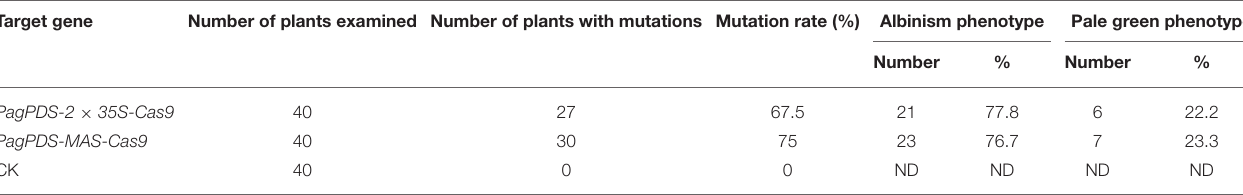
TABLE 1 | Determination of mutation rate in transgenic T 0 poplar plants generated with the PagPDS-2 × 35S/MAS -Cas9 system. Target